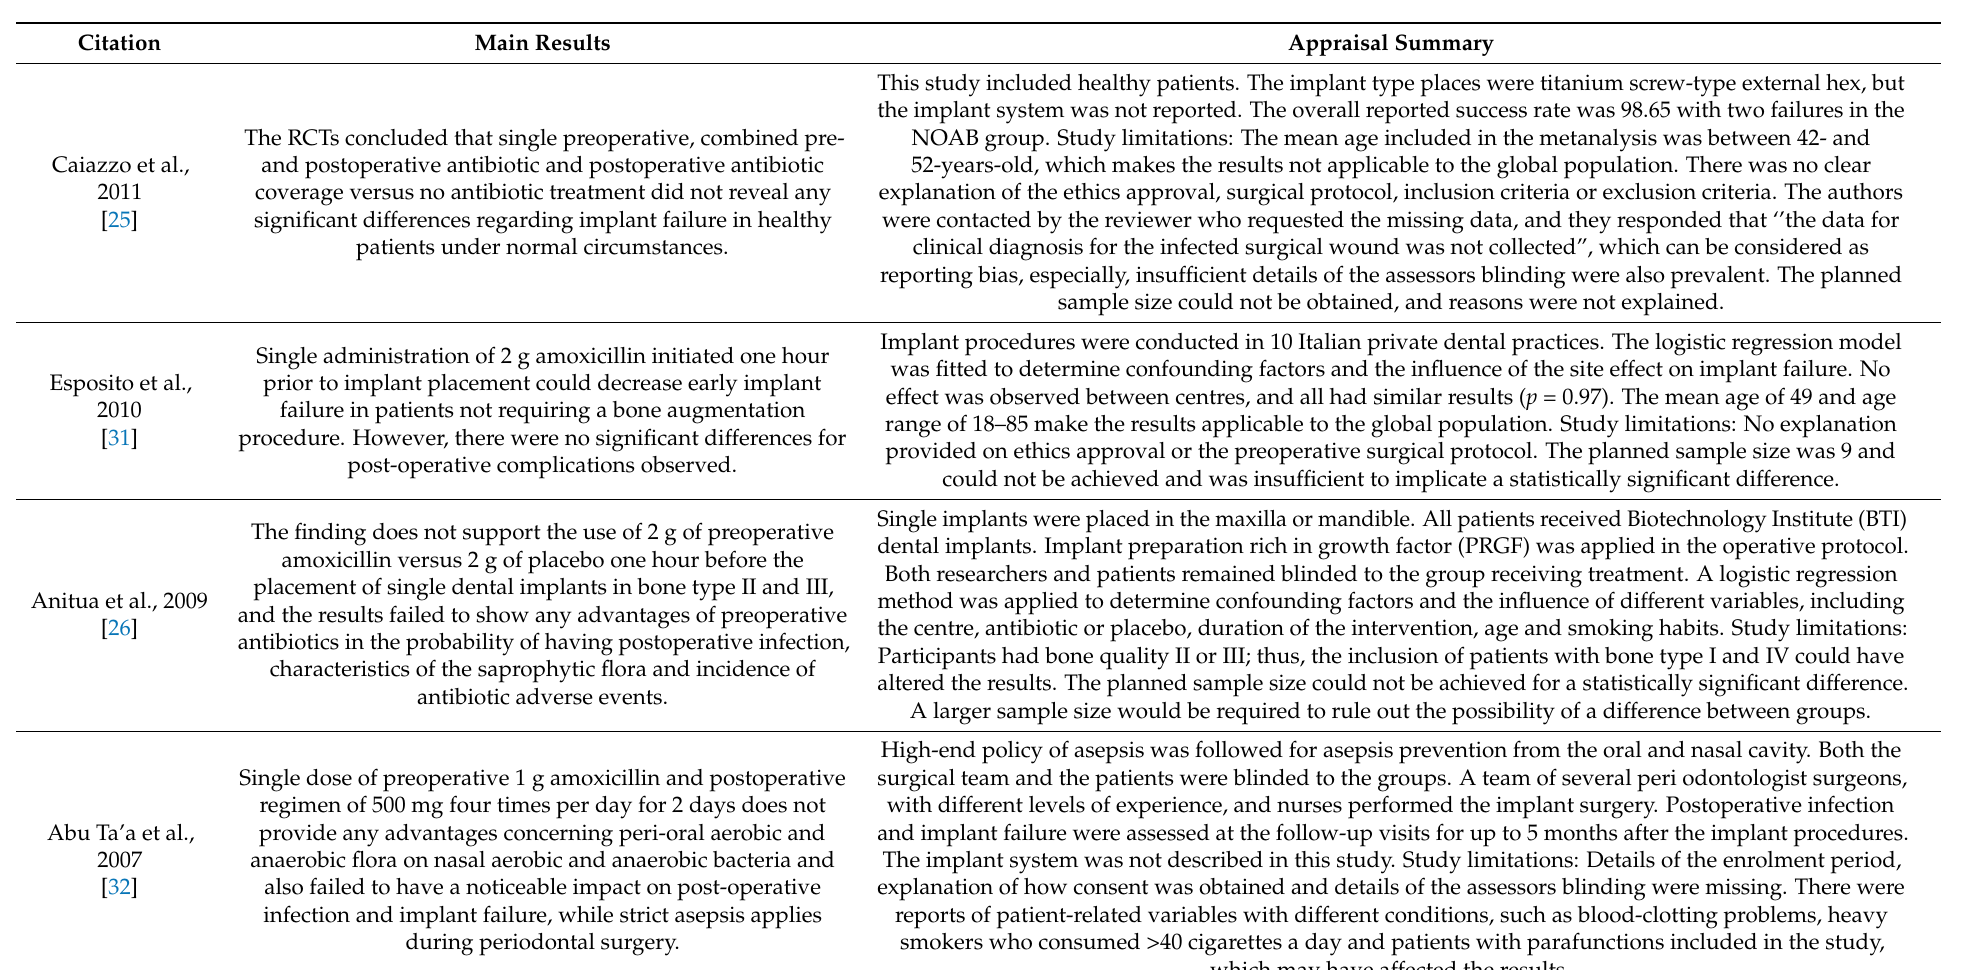
Table 2. The intervention effect of selected